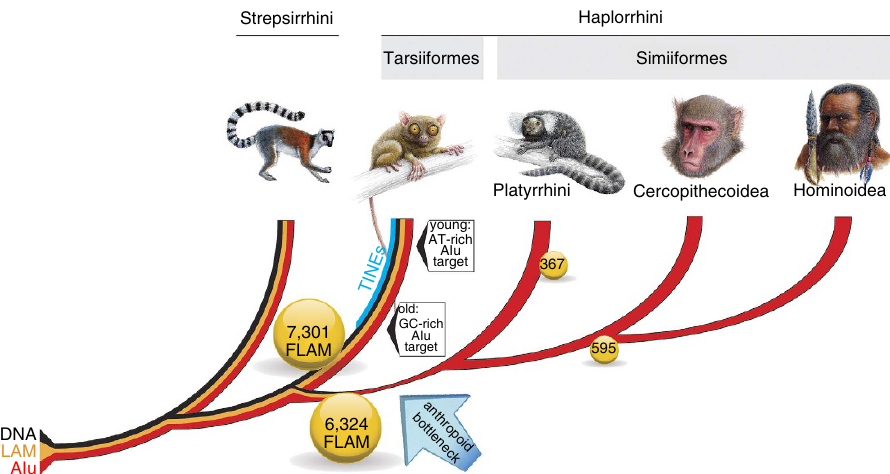
Figure 1 | The Alu and DNA element histories of the main primate lineages. The key position of the tarsier between Strepsirrhini and Simiiformes (Anthropoidea) is depicted. DNA transposons (DNA; black line) and fossil left Alu monomers (FLAMs; orange line) were active at the origin of primates but became inactive sometime after tarsiers diverged from the anthropoid lineage, possibly during an intensive anthropoid population bottleneck. Alu elements were active in all primate lineages (red line). Young tarsier Alu J elements (with perfect target site duplications—TSDs) show a preference for more AT-rich target sequences compared with older Alu J elements (with diverged TSDs), which accumulated in more GC-rich regions. TINE elements evolved on the tarsier lineage (blue line). FLAMs (7,301) were detected on the tarsier branch and 6,324 FLAMs inserted in the common ancestor of anthropoids. Afterwards, the activity of FLAMs within anthropoid lineages was significantly reduced. Only 367 elements were detected in the marmoset (Platyrrhini) and 595 elements were estimated for the lineages leading to human. Drawings of animals are provided by Jon Baldur Hlioberg. Drawings for Tarsiiformes and Hominoidea have been reproduced from Hartig et al. 14 with